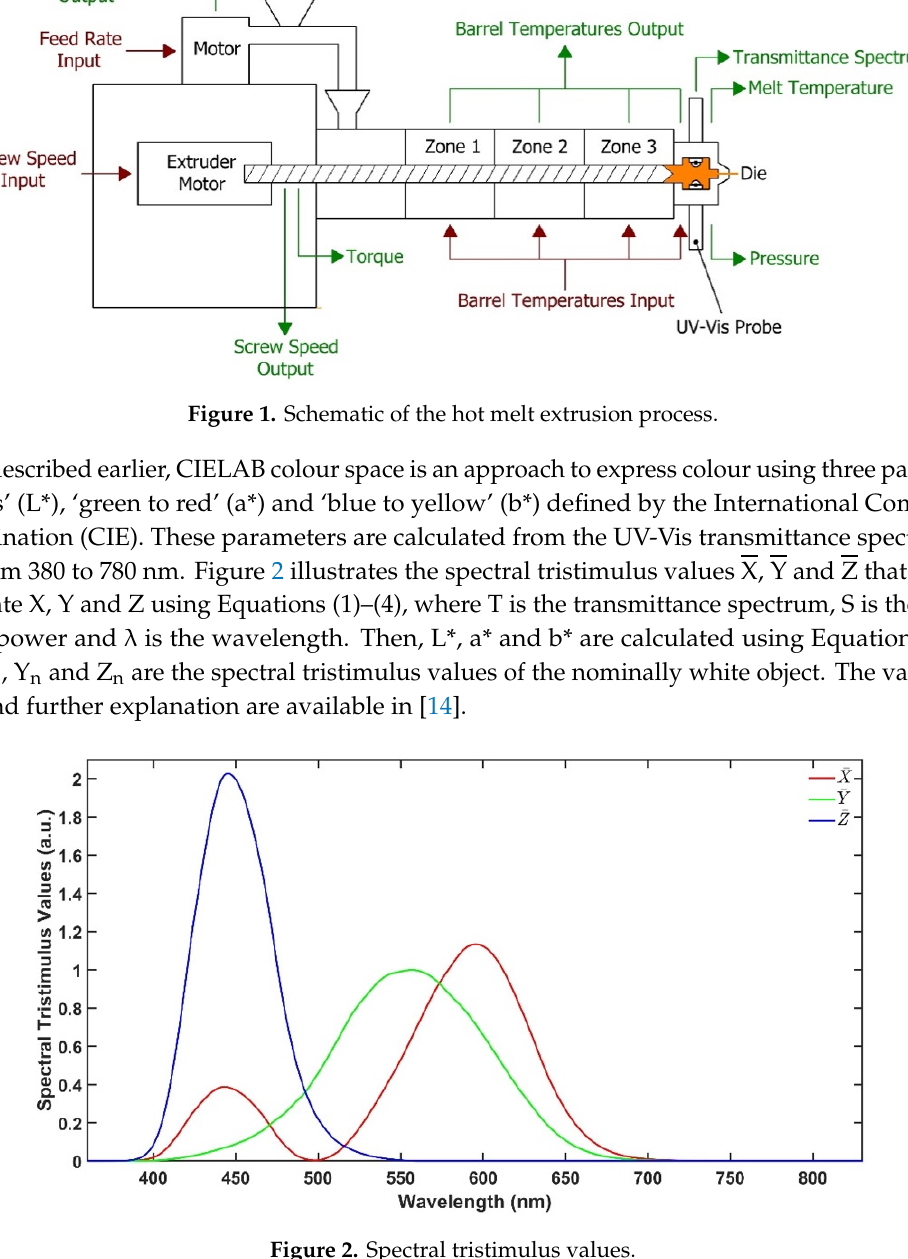
Figure 2. Spectral tristimulus values.